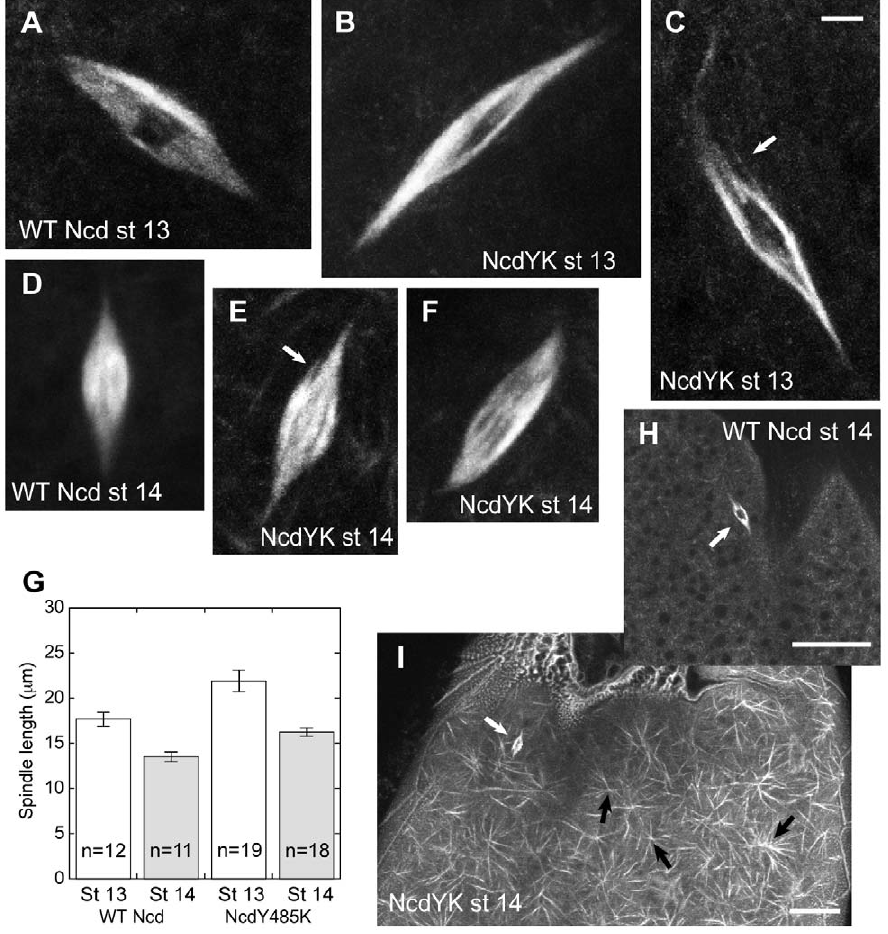
Figure 5. ncdY485K-gfp mutant oocyte MI spindles. (A) Wild-type ncd-gfp or (B, C) ncdY485K-gfp late stage 13 spindles. (D) Wild-type ncd-gfp or (E, F) ncdY485K-gfp stage 14 spindles. (A–F) Arrows, frayed or spurred spindle fibers. Bar, 3 m m. (G) MI spindle length in wild-type (WT Ncd) or mutant (NcdY485K) oocytes (St 13, late stage 13, white bars; St 14, stage 14, gray bars). Error bars, mean 6 SEM. (H) Wild-type ncd-gfp or (I) mutant ncdY485K- gfp stage 14 oocyte cortical region. NcdY485-GFP-decorated cortical microtubules (white) and asters (black arrows) are prominent in ncdY485K mutant oocytes. (H, I) White arrows, MI spindle. Bars, 20 m m.